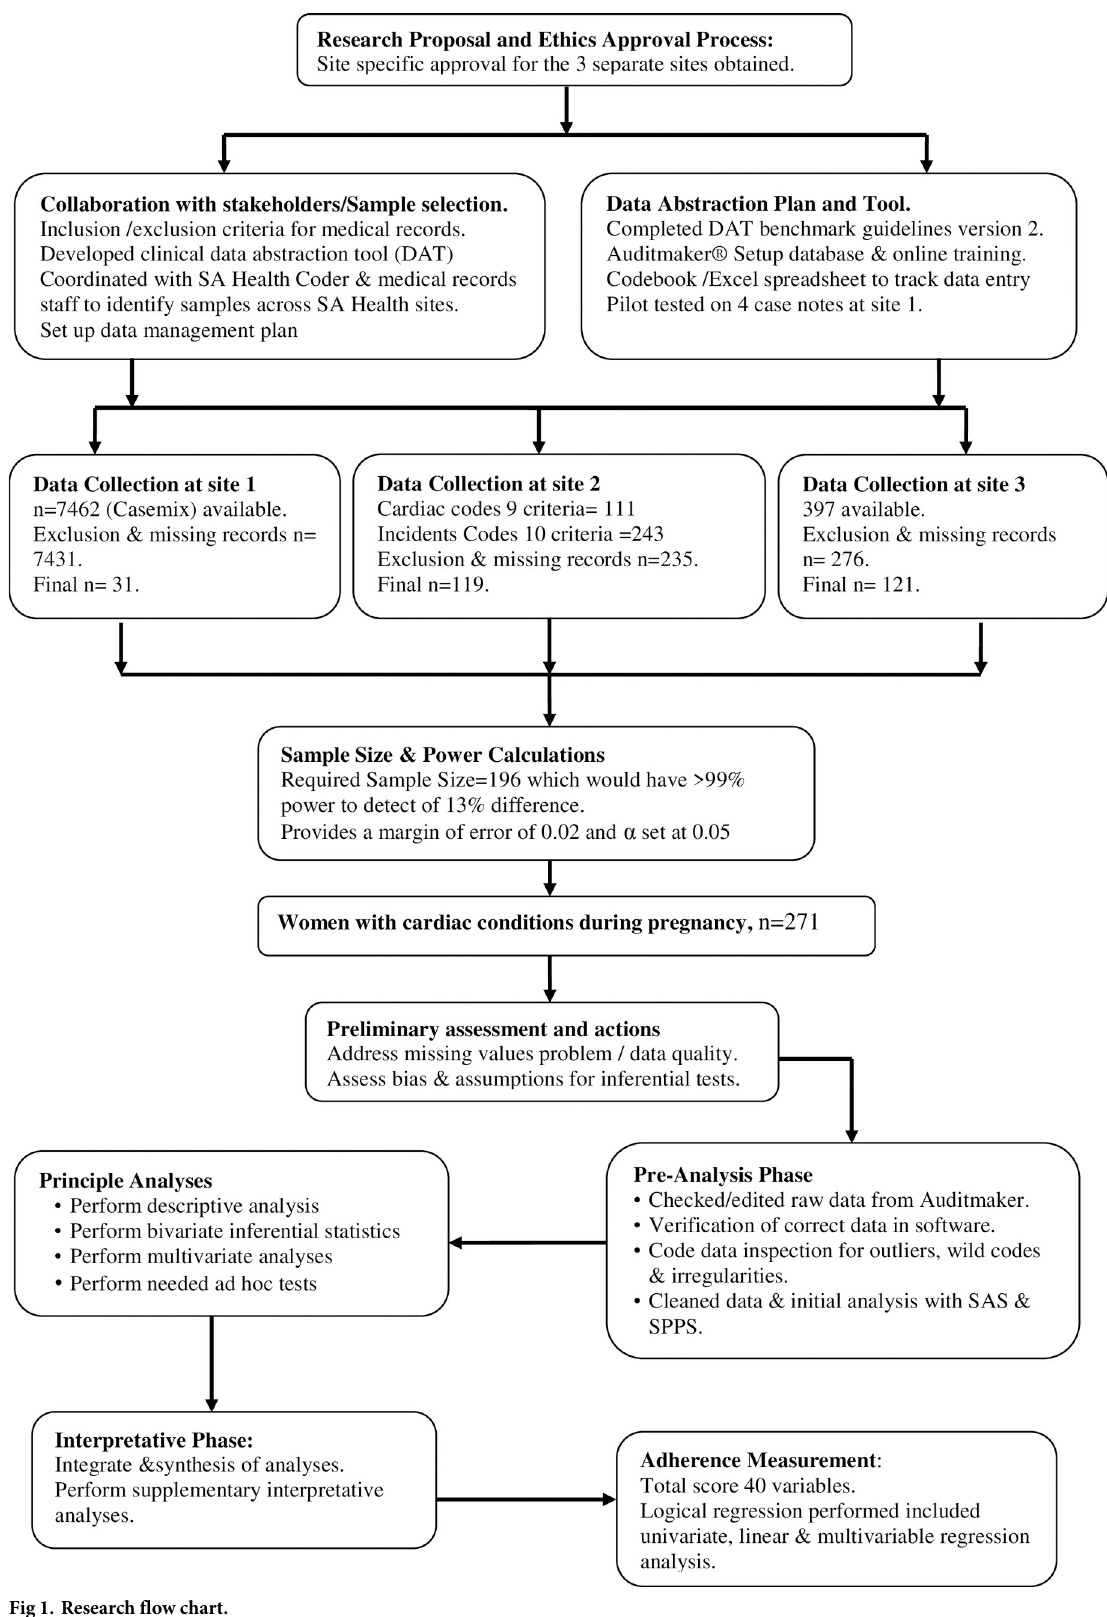
Fig 1. Research flow